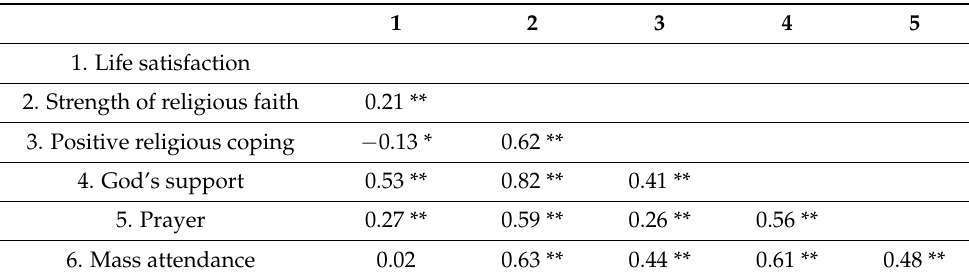
Table 2. Correlation matrix.